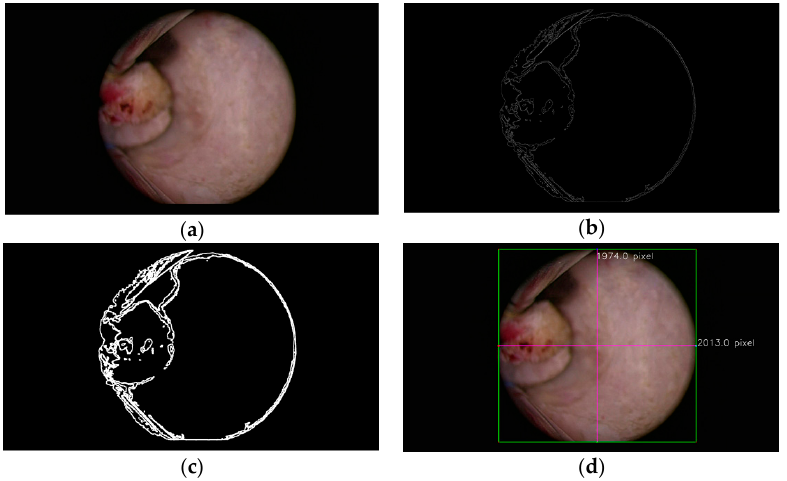
Figure 7. Calculation process of prostate occupation. ( a ) Original image. ( b ) Edge detection image processing. ( c ) Morphology image processing. ( d ) The calculation of the short and long radii. Table 2. Example of the four levels of the bleeding area ratio (BAR).